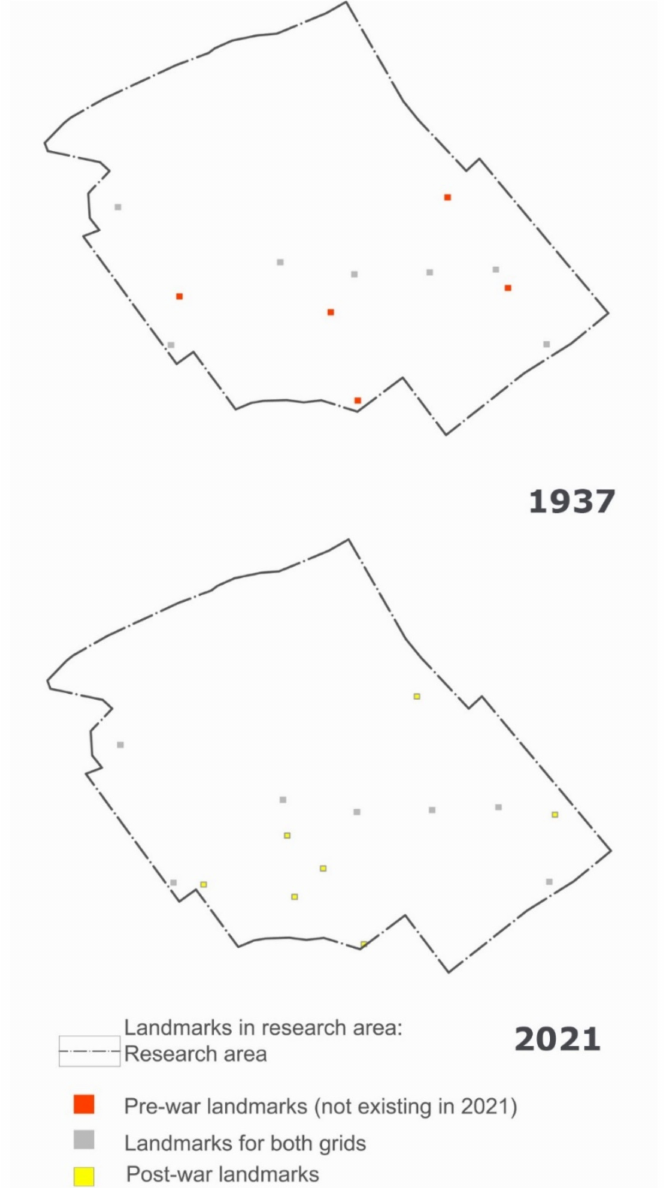
Figure 4. Landmarks on research area in 1937 and 2021; prepared by M.